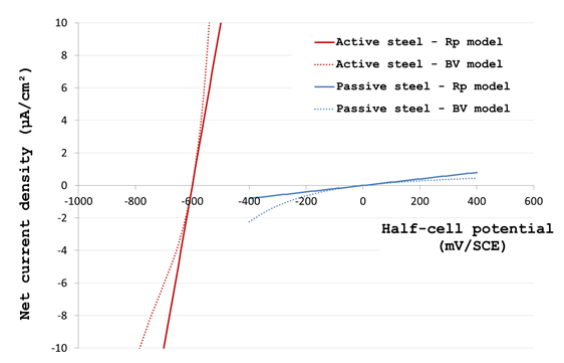
Figure 5. simplified linear approach for the resistance of polarization of both active and passive steel area instead of BV (Butler ‐ Volmer)